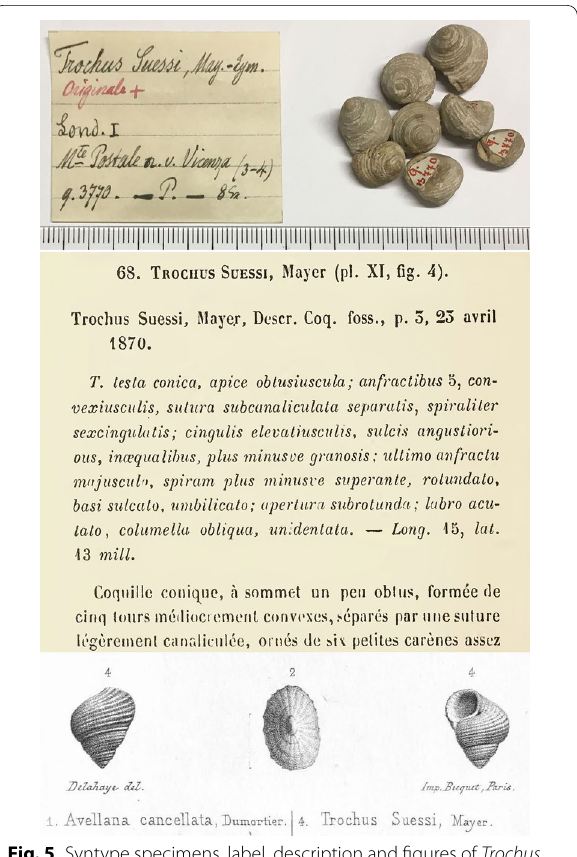
Fig. 5 Syntype specimens, label, description and figures of Trochus suessi Mayer, 1870. The publication appeared in the “Journal de Conchyliologie”. Please note the accurate indication of the dimensions for the species in the